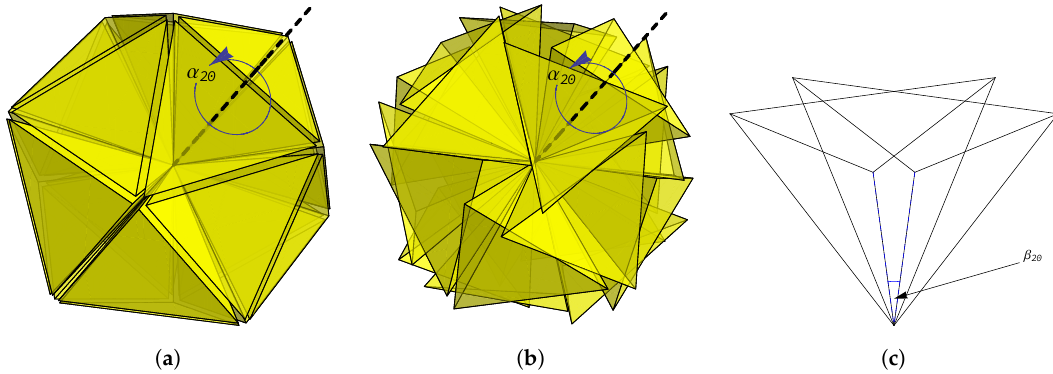
Figure 3. When 20 tetrahedra are organized into an icosahedral arrangement, gaps between adjacent tetrahedra may be “closed” by performing a rotation of each tetrahedron by α 20 about an axis passing from the central vertex through each tetrahedron’s exterior face. When this is done, an angle of β is produced in the projection of faces in a “face junction”. ( a ) Twenty tetrahedra arranged with icosahedral symmetry about a common central vertex. In this arrangement, gaps exist between faces of adjacent tetrahedra. Each tetrahedron is to be rotated by α 20 about an axis passing from the central vertex through its exterior face. ( b ) The tetrahedra after rotation. Like in the cases above, the faces of adjacent tetrahedra have been brought into contact. ( c ) A projection of the “face junction” between two coincident faces in Figure 3b. The angular displacement between the faces is β 20 = β 5 = β .